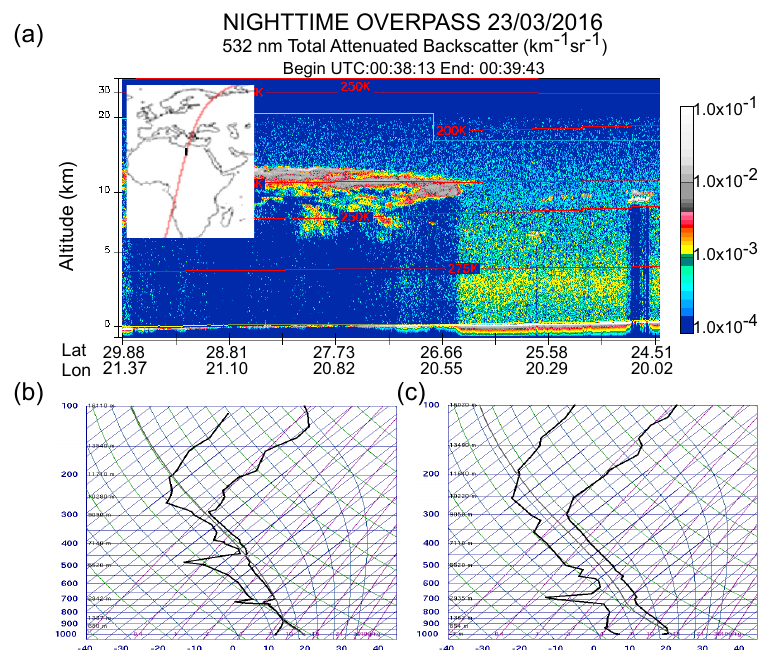
Figure 10. ( a ) Attenuated backscatter quicklook derived from CALIOP (CALIPSO satellite on 23 March 2016 at night during the over passes over the dust source region. ( b ) Skew T-logp diagram of Izmir (western station, WMO number: 17220) at 00:00 UTC of 24 March, 2016. The solid thick lines represent temperature and dewpoint observations. Temperature in ° C and pressure levels in hPa. ( c ) same as ( b ) but for Kartal (northern station, WMO number: 17064)